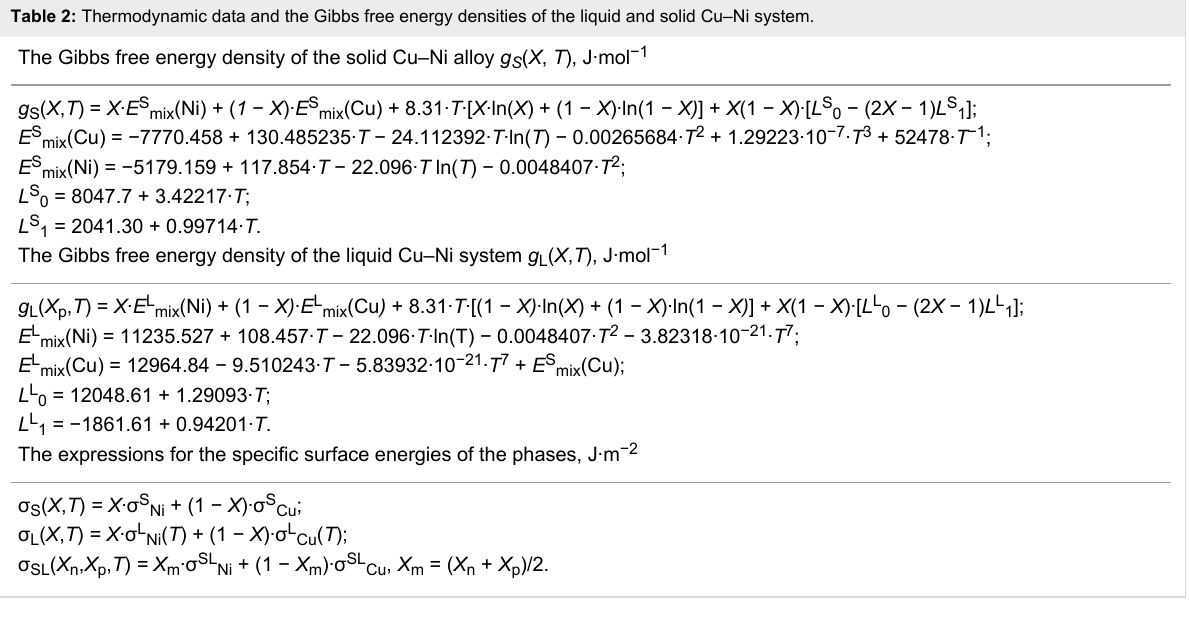
Quantity / Property, measure